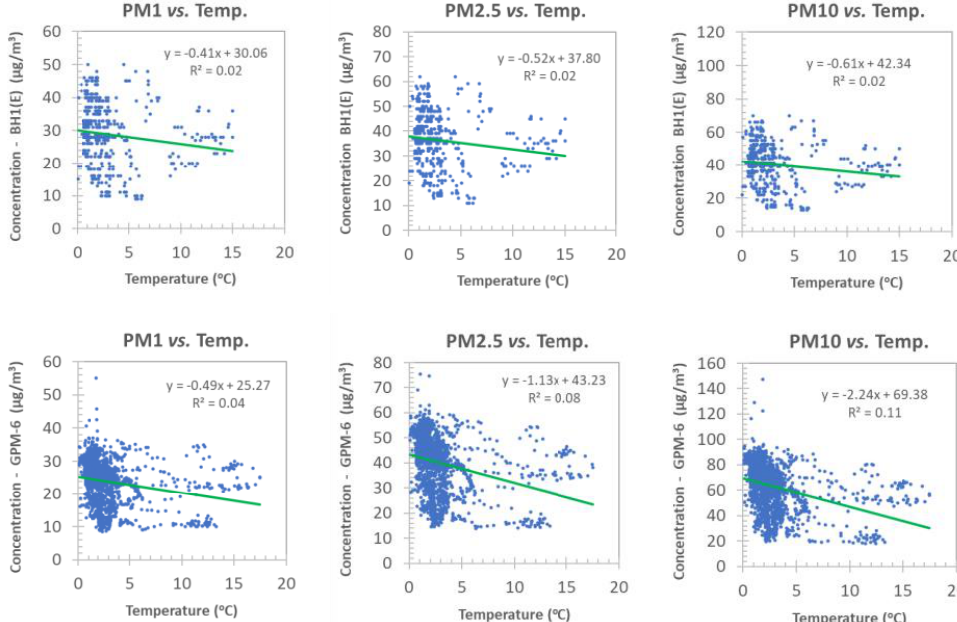
Figure 10. Effects of ambient air temperature on PM x readings of BH1 (upper graphs) and GPM (lower graphs) sensors studied at the suburban site between 6 and 12 December 2021 (sampling rate: 1–5 min, n = 2018).